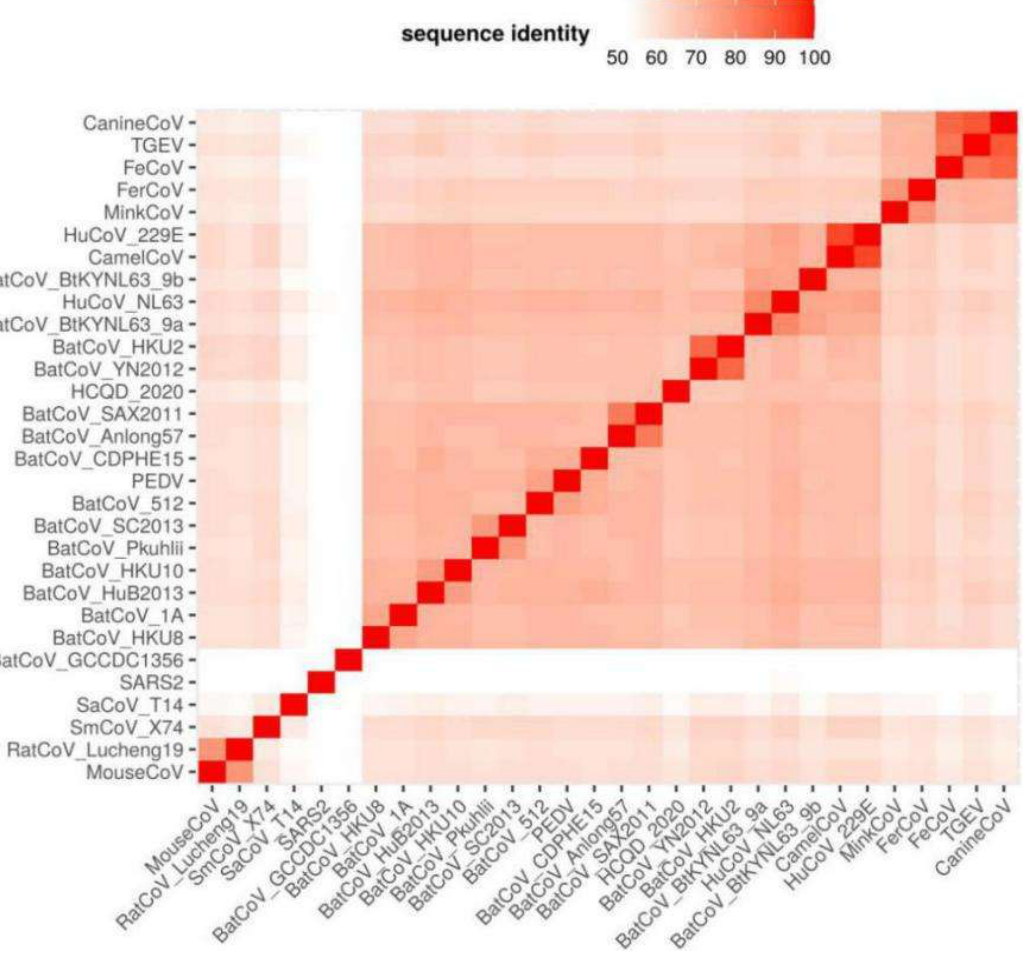
Figure 2. Heatmaps represented whole-genome comparisons between HCQD-2020 and other known species of Alphacoronavirus and Betacoronavirus . The color scale represents the sequence identity in percentage of each sequence pair. It is clear that the similarities between the HCQD-2020 strain and other strains were very